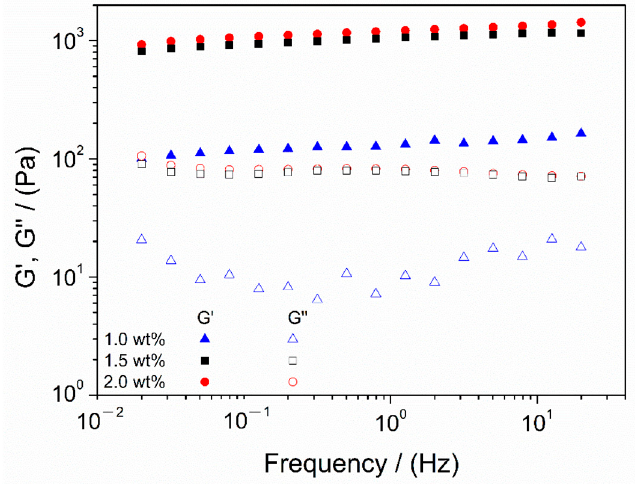
Figure 5. Frequency sweep tests of chitosan hydrogels with different biopolymer concentrations (1.0, 1.5 and 2.0 wt.%) gelatinized at 4 °C. The presented data are the mean values for each system. Table 4. Strain and frequency sweep tests parameters (mean value + standard deviation) for chi- tosan hydrogels with different biopolymer concentrations (1.0, 1.5 and 2.0 wt.%) gelatinized at